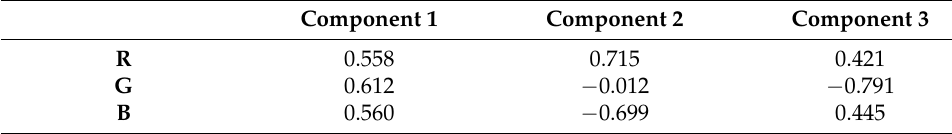
Table 6. Eigenvectors derived from the principle component